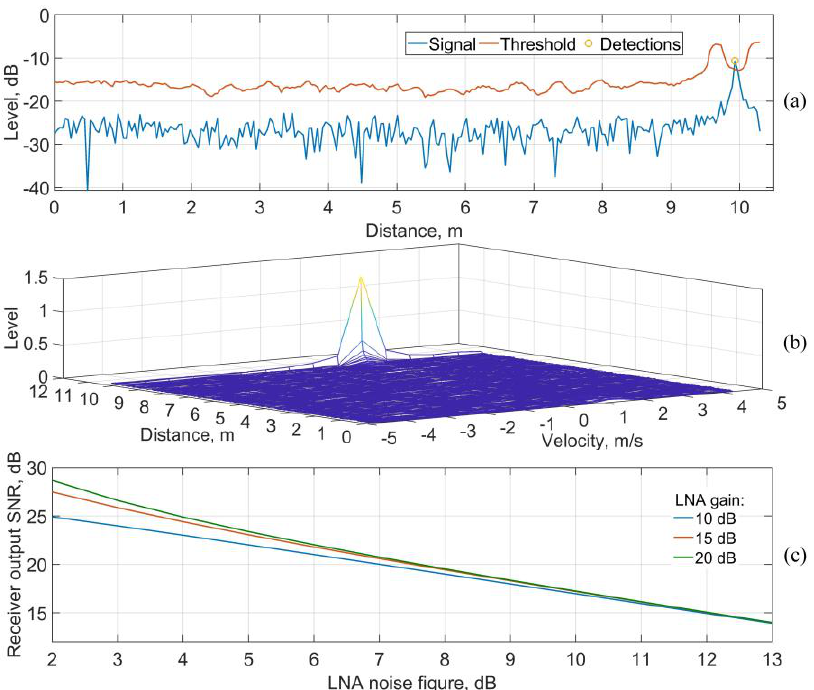
Fig. 8. Examples of second-level model simulation results: range-FFT plot (a), range-Doppler plot (b), and receiver output SNR vs LNA noise figure